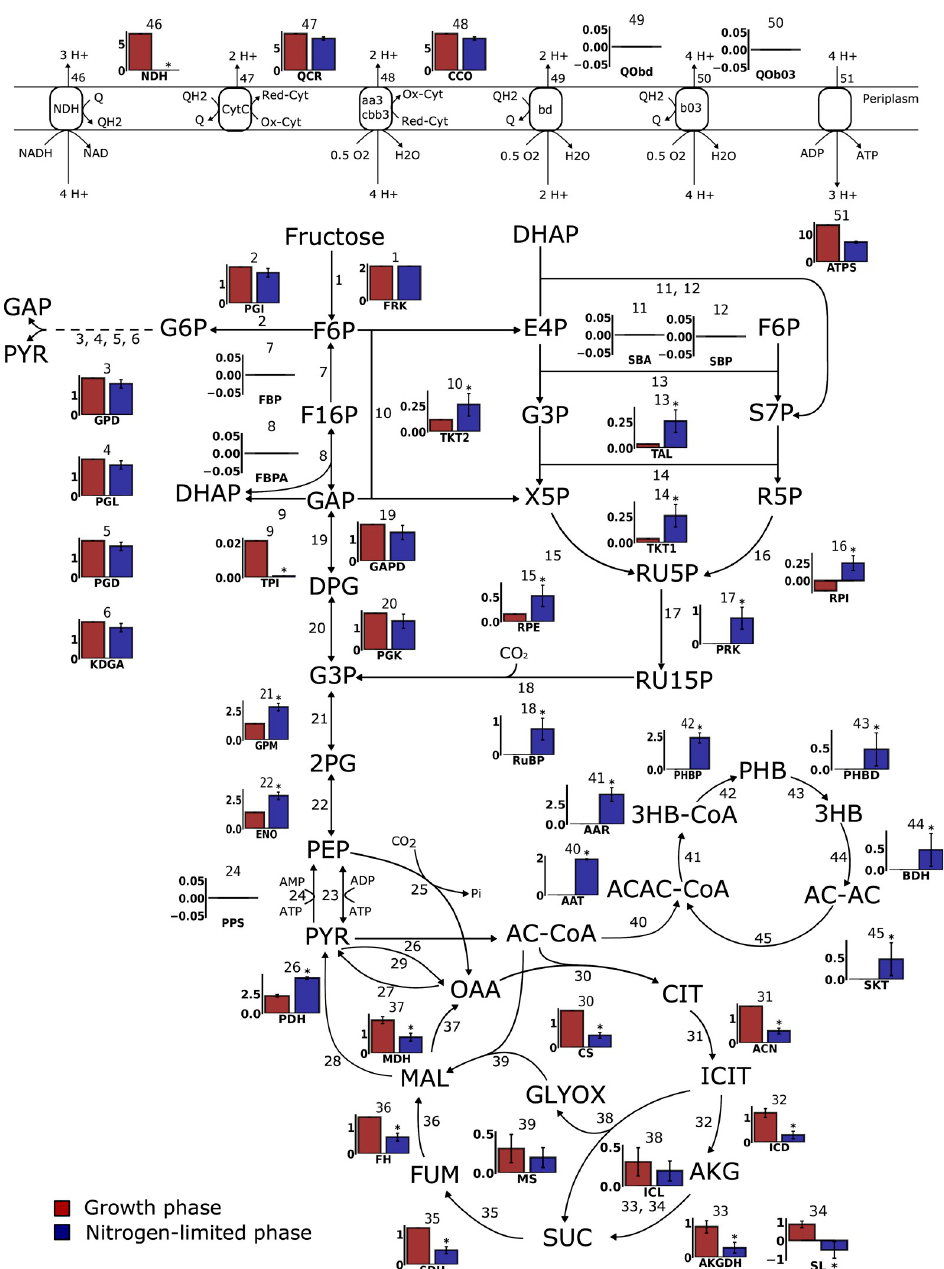
Fig 5. Flux diagram of the central carbon metabolism, electron transport chain and the PHB cycle comparing the predicted flux in the growth and nitrogen-limited phase. The bar charts show the mean flux value from the flux sampling simulated on i CN1361-f16 (red) and i CN1361-f26 (blue). Reactions that were predicted to have significantly up-regulated or down-regulated flux in i CN1361-f26 are highlighted with an asterisk. See the abbreviations section for the metabolite and reaction